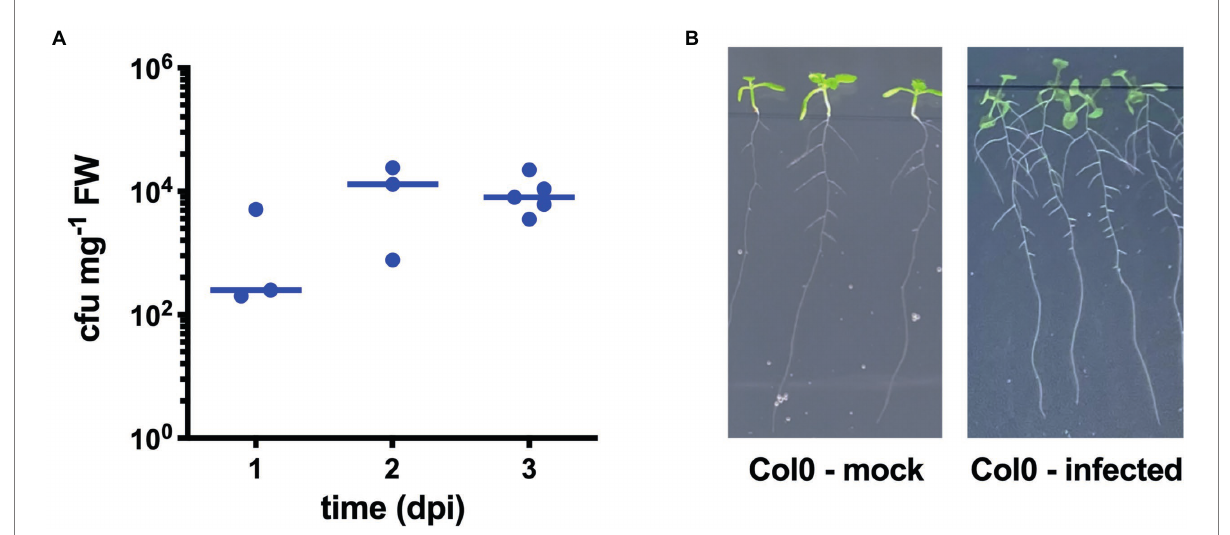
FIGURE 1 Salmonella Typhimurium ATCC14028 (STM) infection of Arabidopsis thaliana shoots. (A) Enumeration of STM recovered from Col-0 shoots at different time points, each symbol corresponding to a single shoot. Horizontal lines indicate median values. The diagram shows a representative experiment of at least three independent assays. (B) Representative pictures of Col-0 seedlings at 3 dpi showing an average increase of lateral roots.